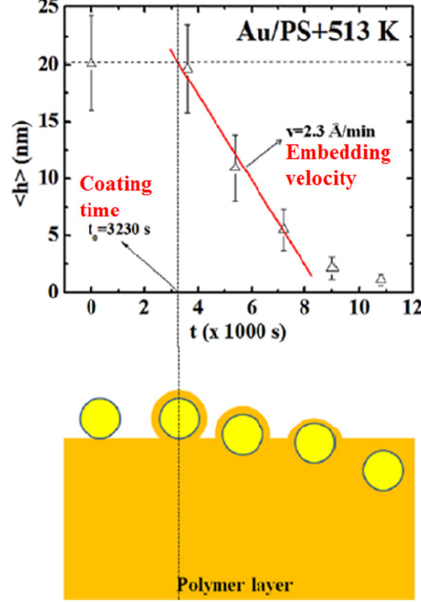
Figure 15. ( a ) Evolution of the mean NPs height < h > as a function of the annealing time t for each fixed annealing temperature T for the investigated systems. ( b ) Evolution of number N E of the embedded NPs as a function of the annealing time t for each fixed annealing temperature T for the investigated systems.